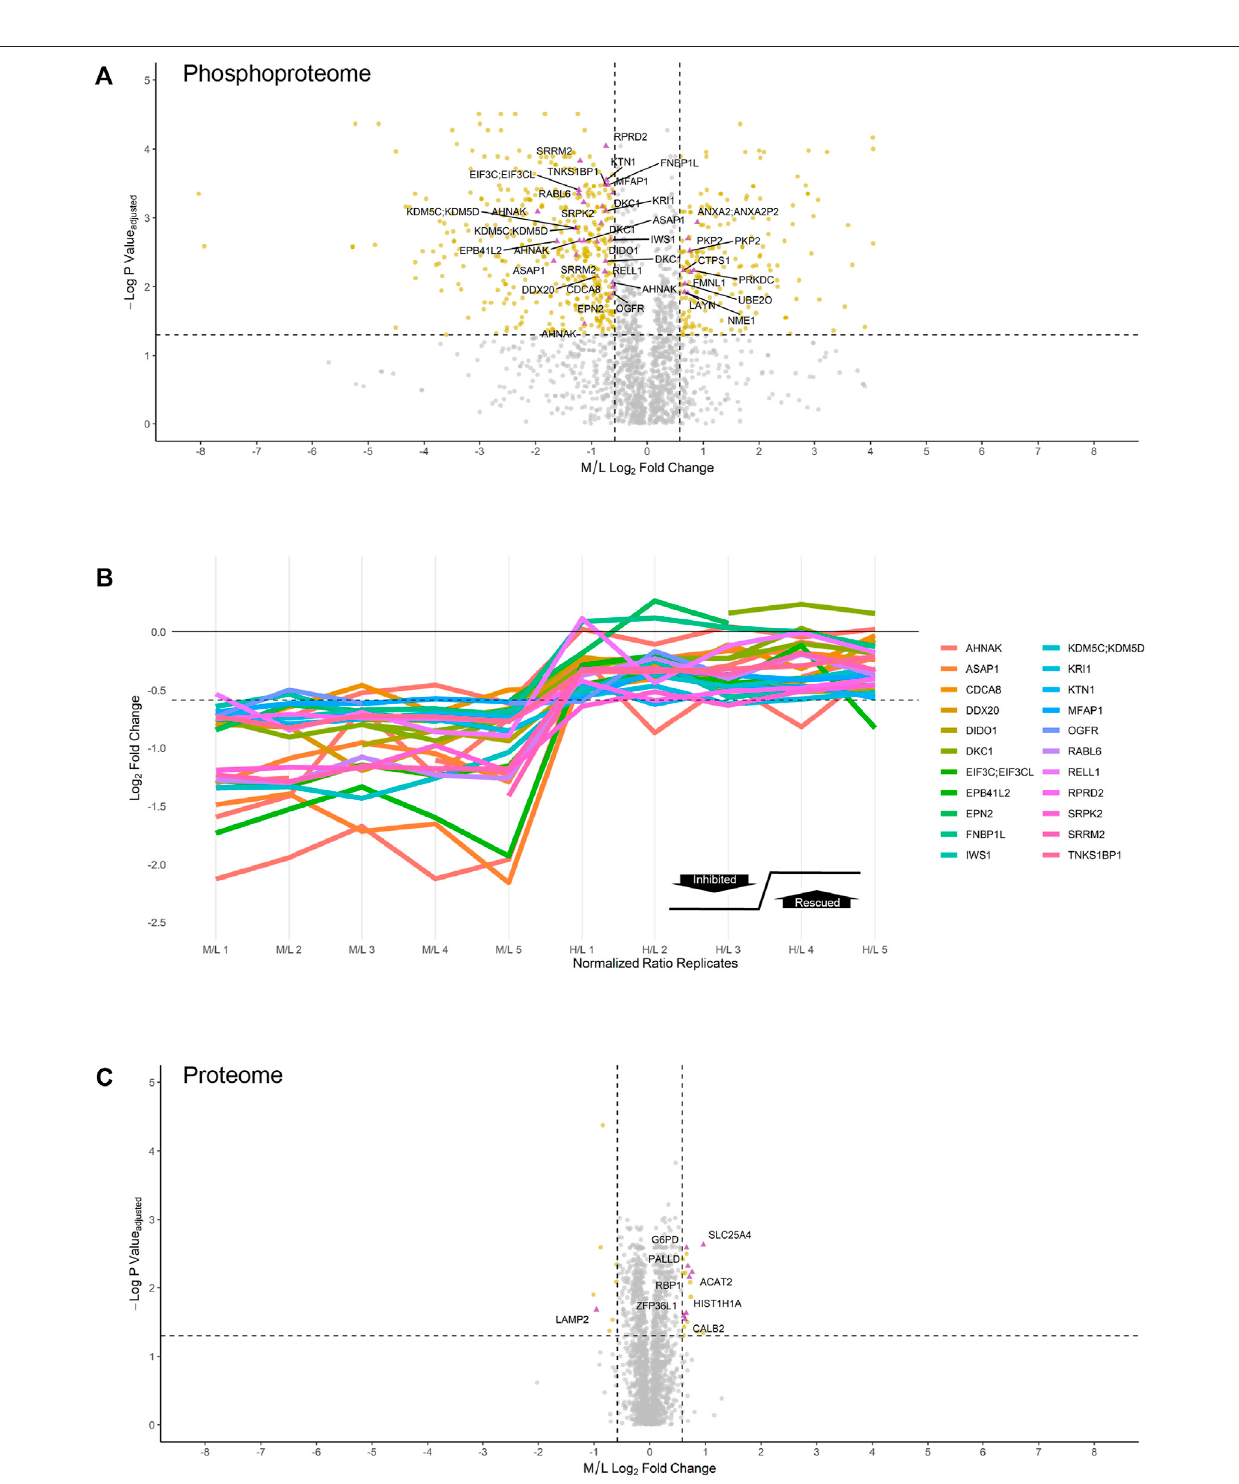
FIGURE4| Inhibitionandrescuepro fi leofCSNK2substrates.Differentialexpressionof (A) phosphopeptidesand (C) proteinsaftertreatingU2OScellsexpressing CSNK2A1-WT with 30uM of CX-4945 for 4 h. Phosphopeptides/proteins highlighted in gold are signi fi cantly down- or upregulated 1.5-fold. Phosphopeptides/proteins highlighted in purple demonstrate rescue in U2OS cells expressing CSNK2A1-TM with 30uM of CX-4945 for 4 h. Rescued phosphopeptides are labelled with the gene nameofthecorrespondingprotein.Verticaldashedlines( − /+0.585)represent1.5-folddown-andupregulation,respectively.Thehorizontaldashedlinerepresents an adjusted p -value cutoff of 0.05 (B) Inhibition and rescue pro fi les of CSNK2 substrate phosphopeptides. The horizontal dashed line is representative of signi fi cant inhibition (-0.585).